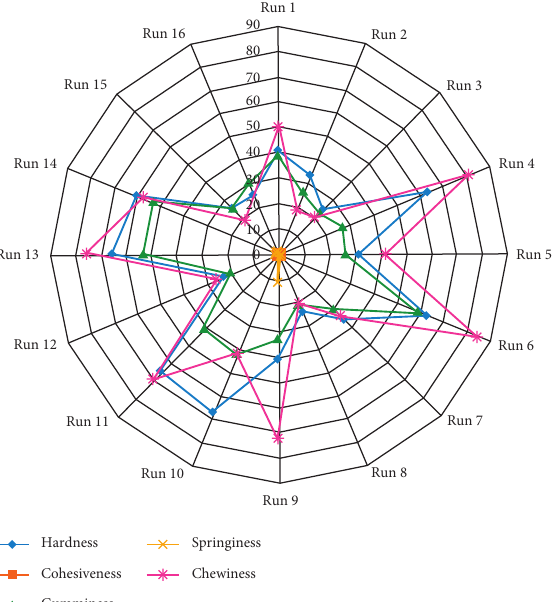
Figure 3: Web diagram representing the textural profile analysis (TPA) of all 20 sample runs of fruit peel macaroni obtained by RSM